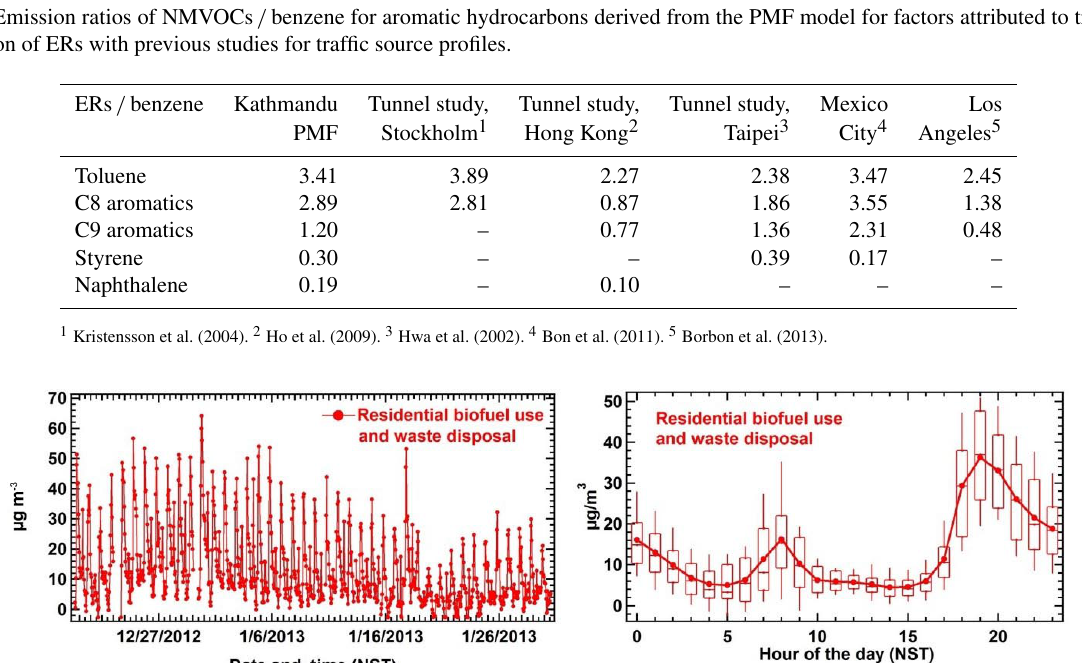
appear as a separate factor in the PMF solution. Therefore, Factor 2 was attributed to residential biofuel use and waste disposal sources